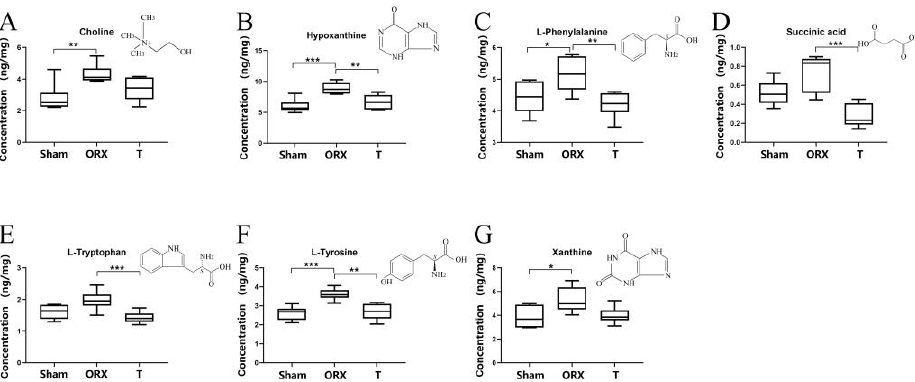
Figure 5. Box diagram of the concentration of different metabolites and their chemical structures ( A – G ) in different groups. * p < 0.05 vs. ORX, ** p < 0.01 vs. ORX, and *** p < 0.001 vs. ORX.